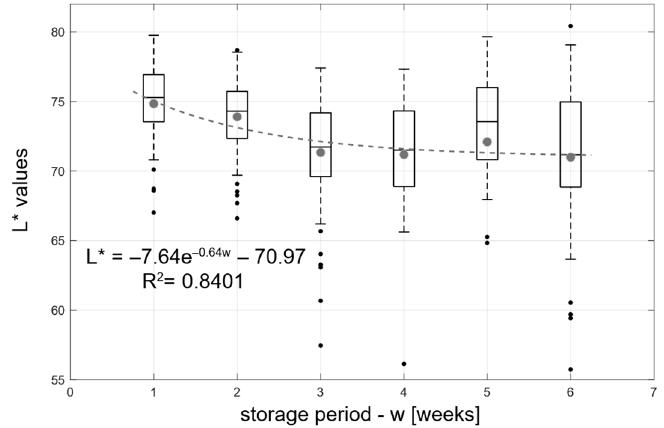
Figure 3. Effect of ambient temperature on L* values of apple during storage: lightness factor decreases to a specific limit.